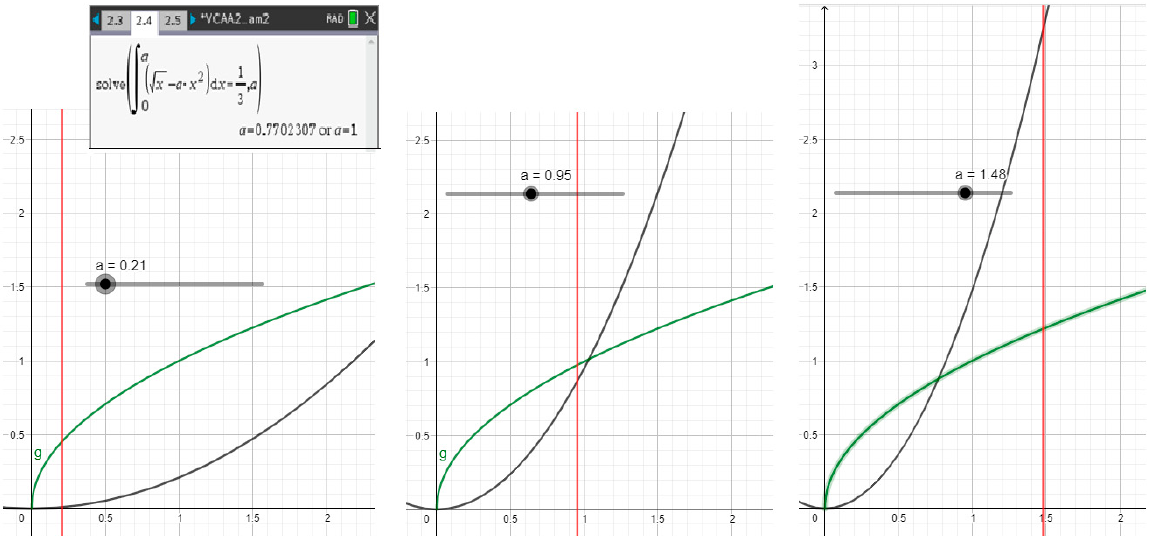
Figure 9. The 2021 Mathematical Methods Examination 2, Question 2f (abbreviated) showing graphs for different values of the parameter. 2f. Find the values of a ∈ (0,2] such that the area defined by the region(s) bounded by the graphs o f y = ax 2 and y = √𝑥 and the lines x = 0 and x = a is equal to 1 3